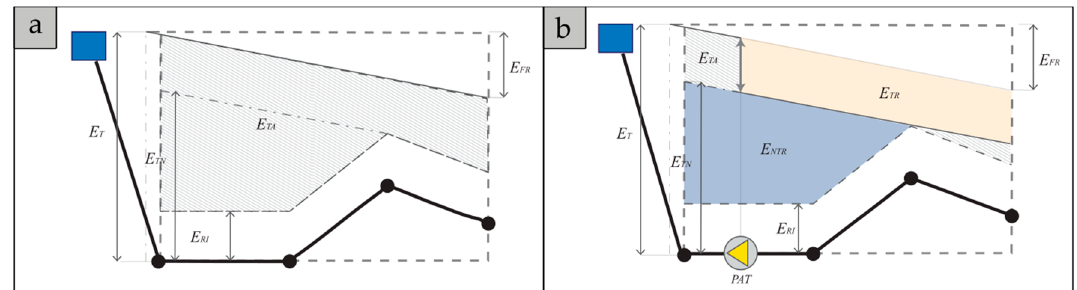
Figure 2. ( a ) Water distribution system without pressure management. ( b ) Water distribution system with PATs installed.